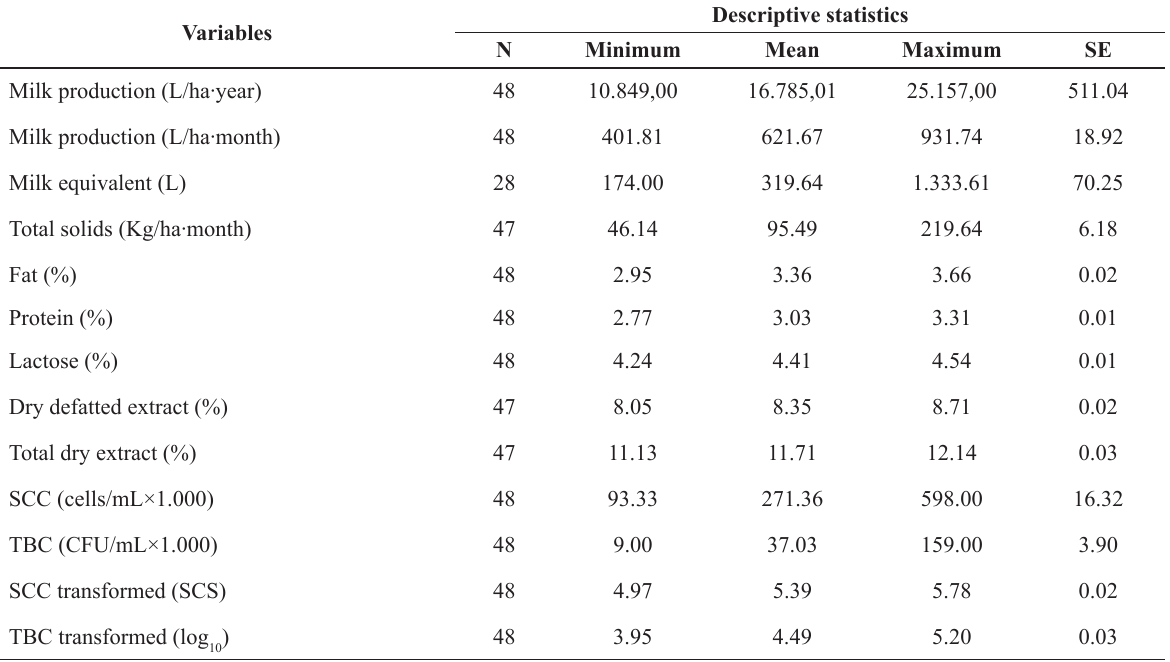
Descriptive statistics of milk production and composition, somatic cell count and total bacterial count.